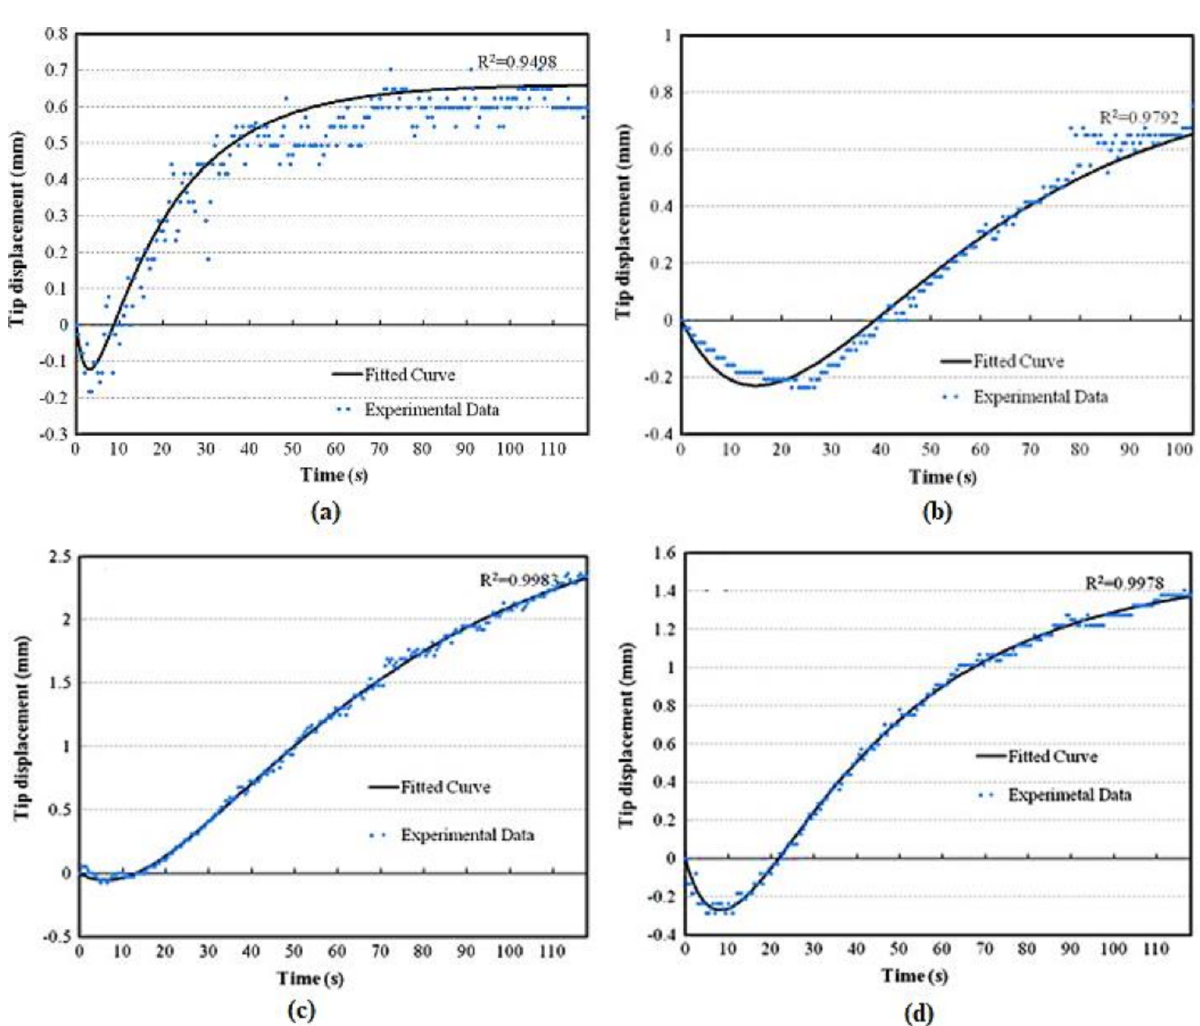
Figure 11. ( a ). Tip-displacement of the graphene-based polymer composite actuator in excitation-voltage of 3 V DC; ( b ). At 0.1 wt. percent graphene loading; ( c ). At 0.25 percent graphene loading and ( d ). At 0.5 percent graphene loading. Reproduced with permission from